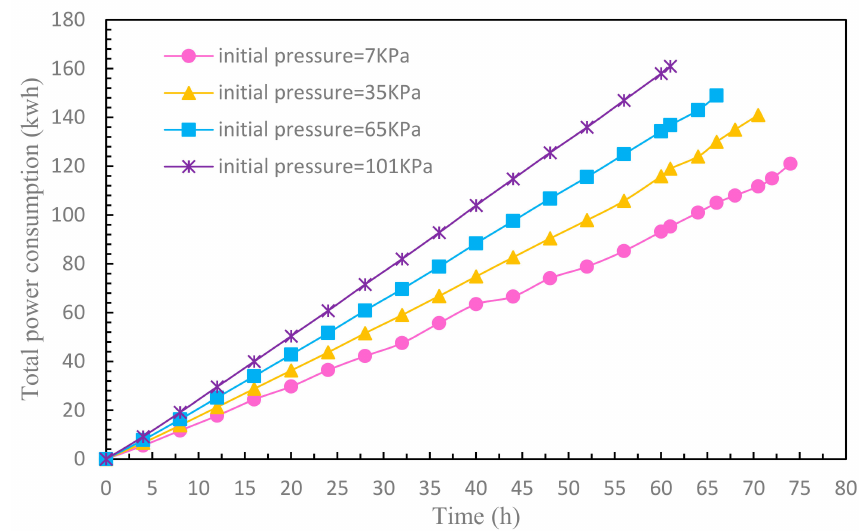
Figure 8. Total power consumption under different initial pressures.